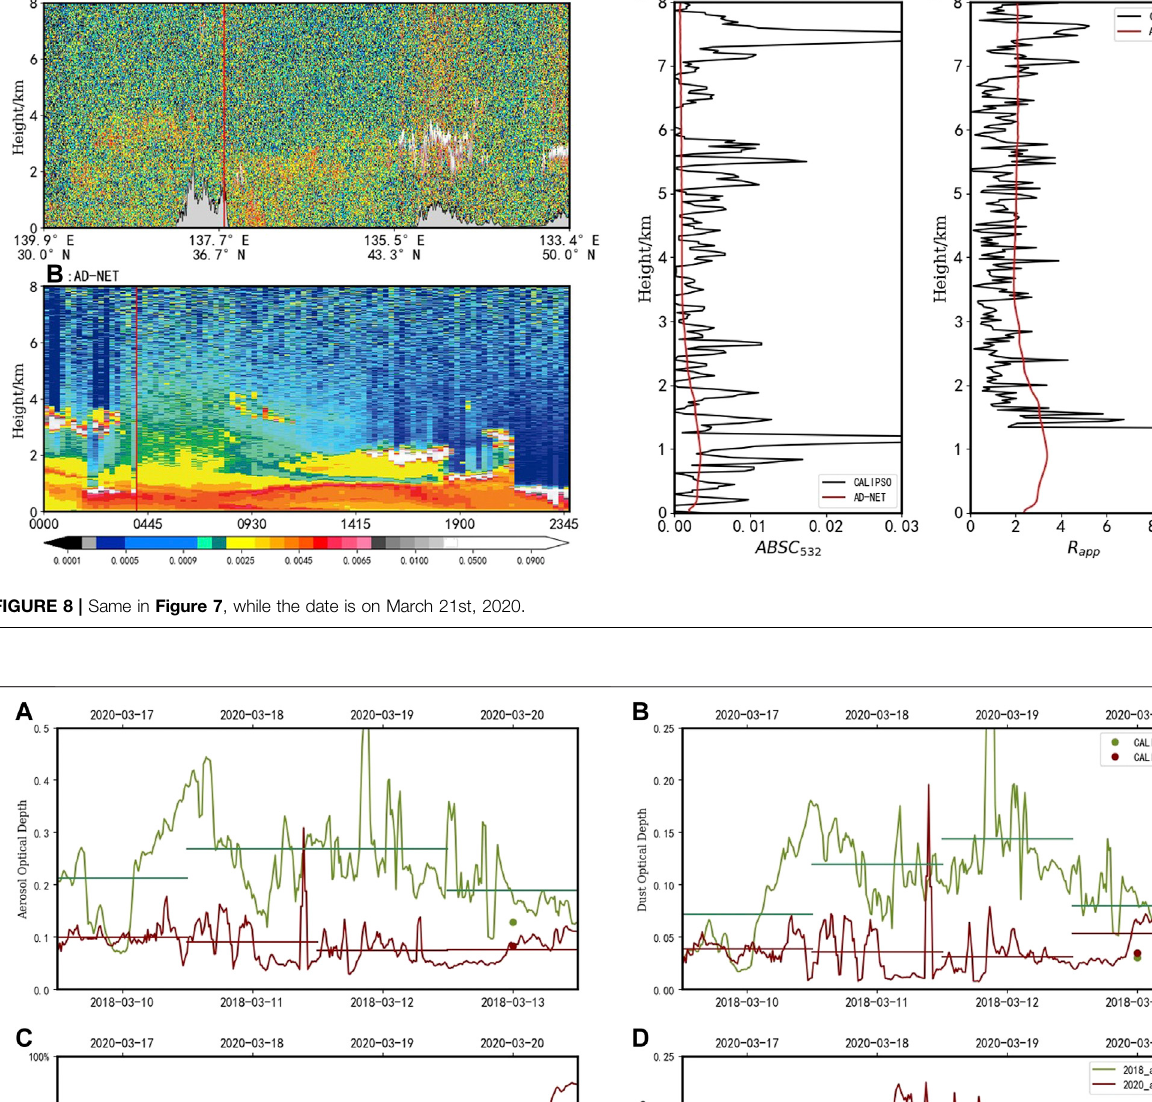
Frontiers in Environmental Science |